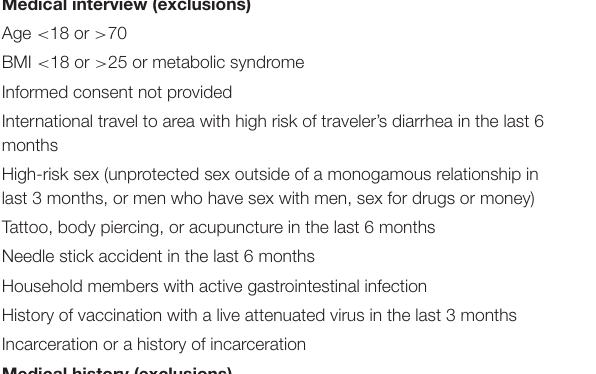
TABLE 1 | Exclusion criteria for patients with UC. Informed consent not provided Infectious enterocolitis Receiving local therapy Serious disease, such as liver disease, kidney disease, heart disease, or other serious complications Autoimmune disease Pregnant women and all cases with the possibility of pregnancy Allergic diseases Antibiotic therapy in the past 3 months